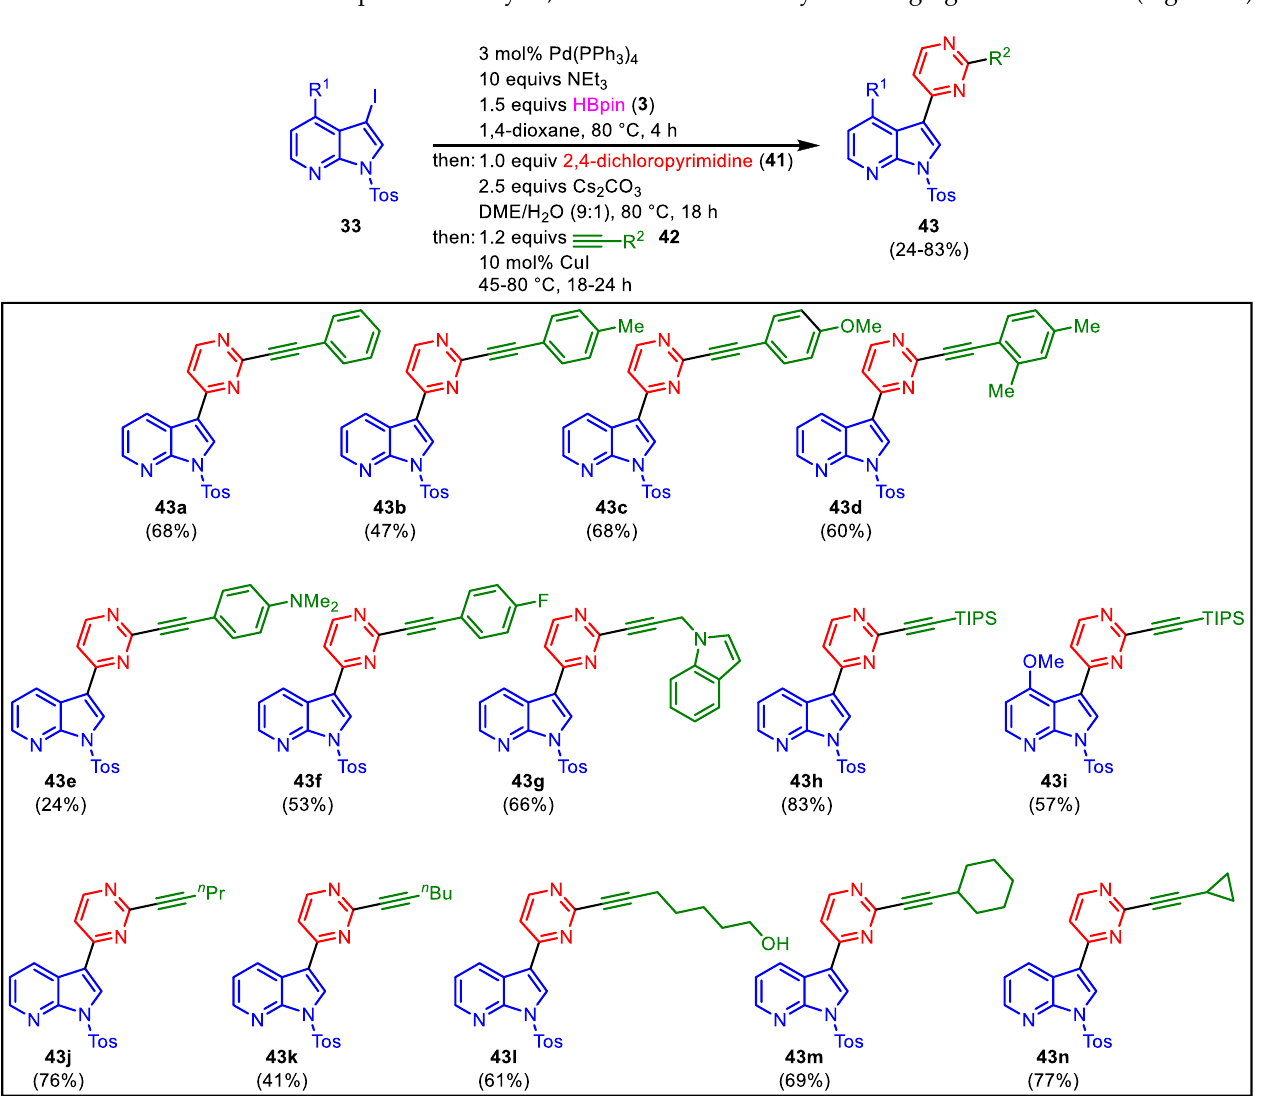
Figure 26. One-pot MBSC initiated three-component MBSC-Sonogashira synthesis of meriolin derivatives 43 by Drießen et al. [55].